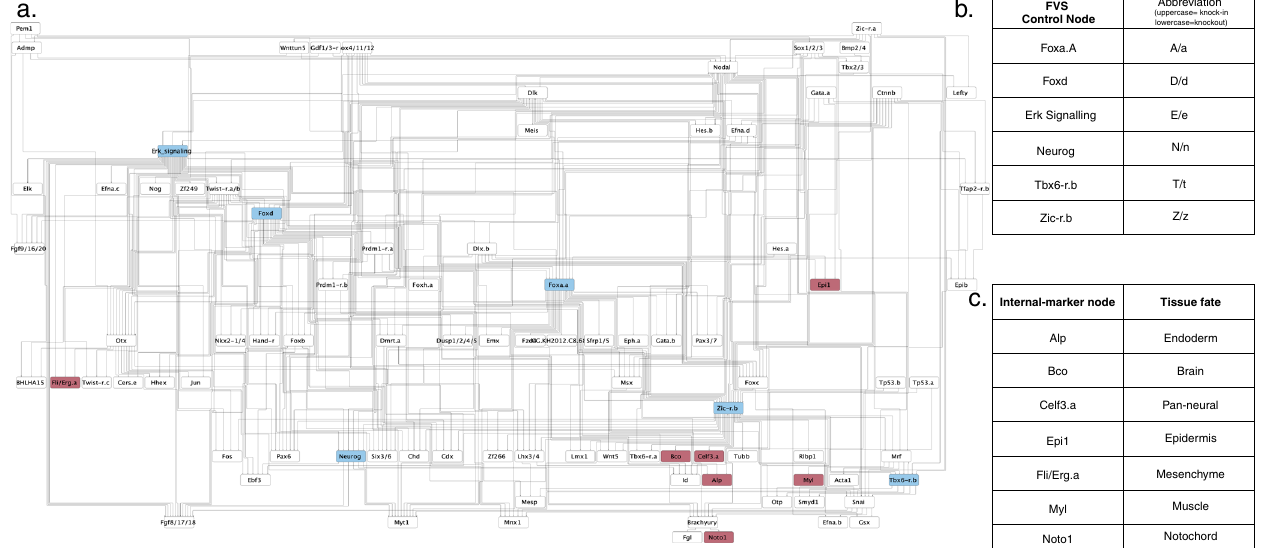
Fig. 3 Cell fate speci fi cation in ascidian embryo model. a Gene regulatory network of cell fate speci fi cation in the ascidian embryo Ciona intestinalis from Kobayashi et al. 55 . The network contains 92 nodes and 329 edges. Nodes highlighted in blue are FVS control nodes. Nodes colored in magenta are the internal-marker nodes used to evaluate if the perturbations on FVS control nodes successfully speci fi ed the desired cell fate. b The six control nodes identi fi ed by Kobayashi et al. that comprise the network ’ s minimal feedback vertex set (FVS). Uppercase or lowercase abbreviations for each node indicate up or downregulation of the FVS control node in a given combination of perturbations (see Fig. 4). These nodes are used as the FVS control nodes in our simulations. c The seven internal-marker nodes and the respective tissue fates where they are upregulated as identi fi ed by Kobayashi et al. experimental studies. These nodes were also used to identify successful perturbations in our